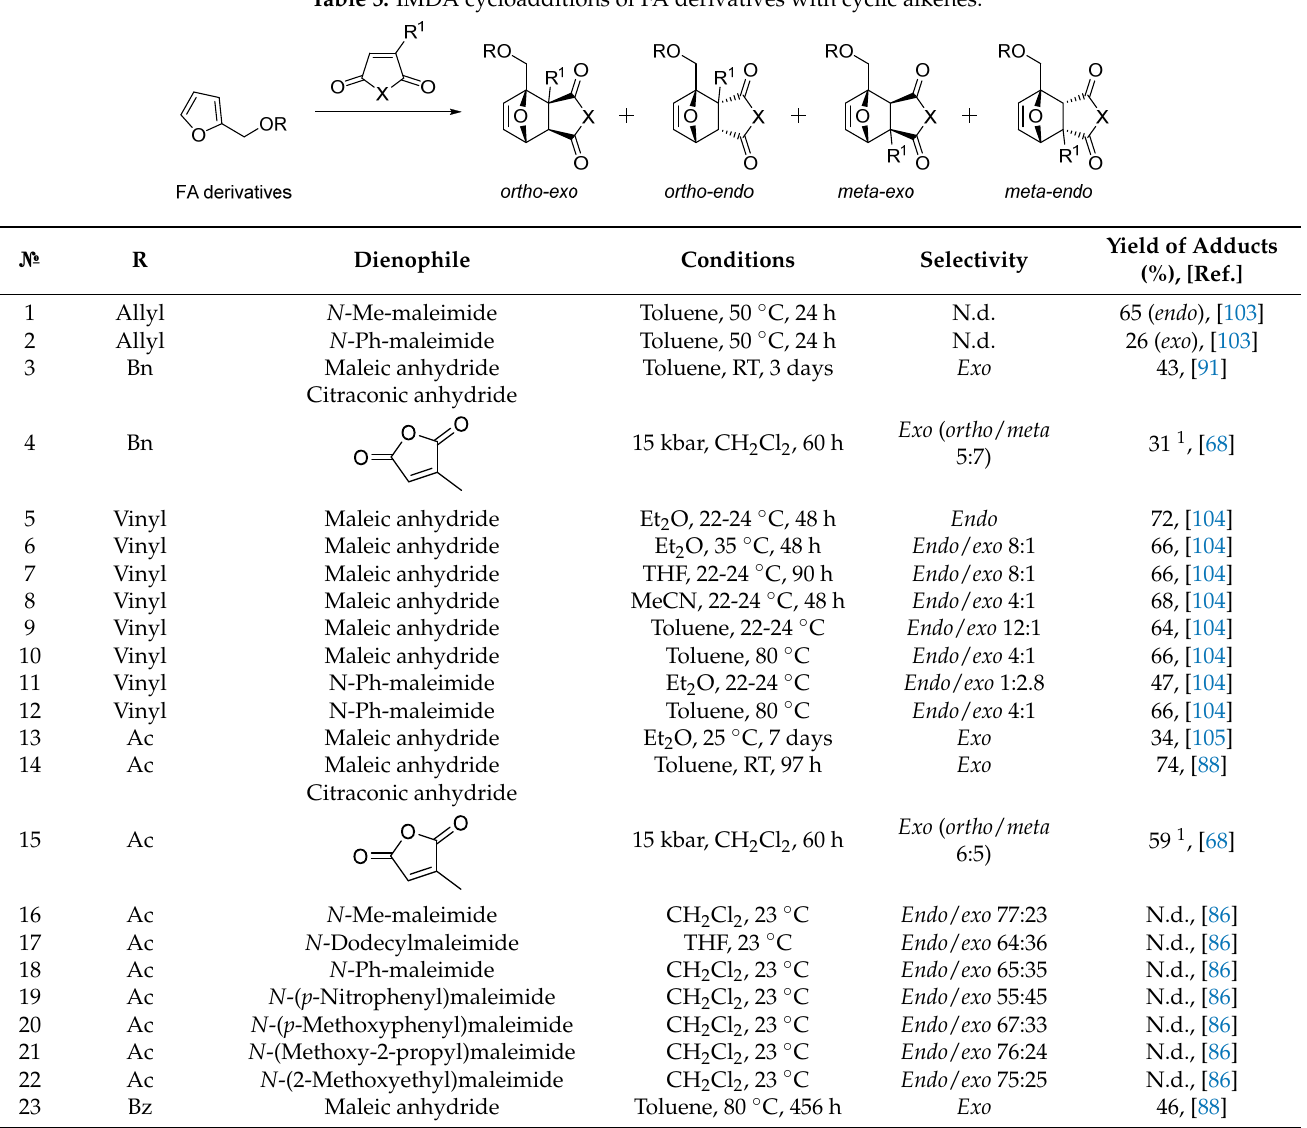
Table 5. IMDA cycloadditions of FA derivatives with cyclic alkenes.